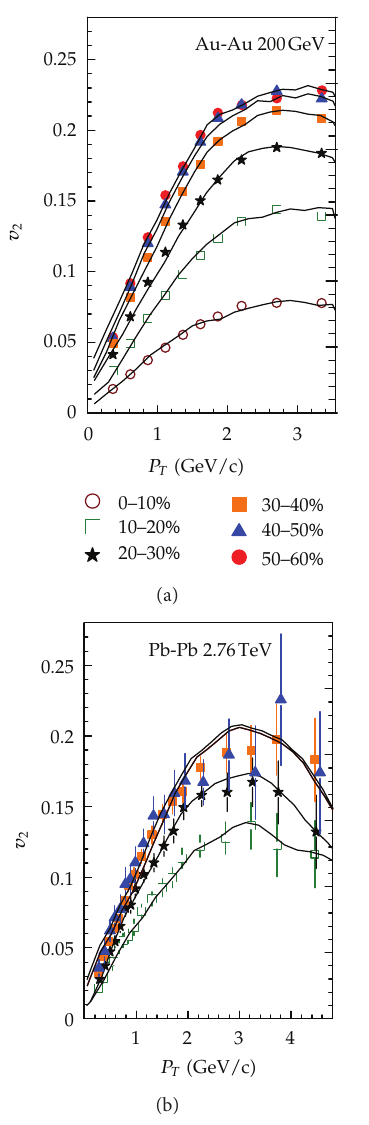
Figure 1: 𝑣 2 versus 𝑃 𝑇 in √𝑠 𝑁𝑁 = 200GeV Au-Au collisions and √𝑠 𝑁𝑁 = 2.76 TeV Pb-Pb collisions. Experimental data taken from the PHENIX Collaboration [20] and the ALICE Collaboration [10] are shown with the scattered symbols. Our results calculated from the multisource model are shown with the curves.